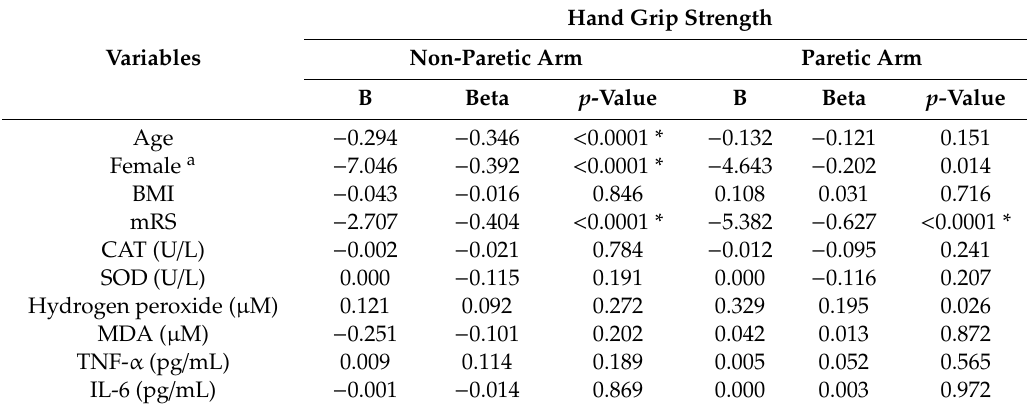
Table 3. Multiple linear regression analysis of hand grip strength with variables in stroke patients.